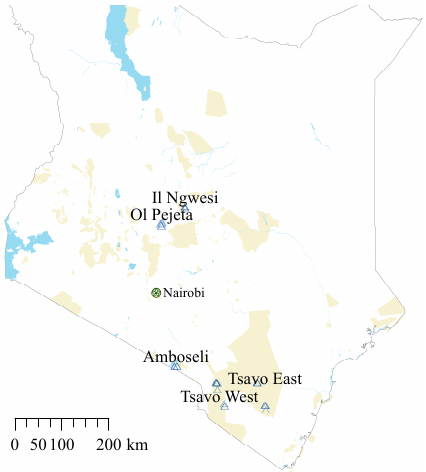
Figure A1. Map of the five protected areas in southern Kenya where field work was conducted. The positions of individual plots are marked with blue triangles.